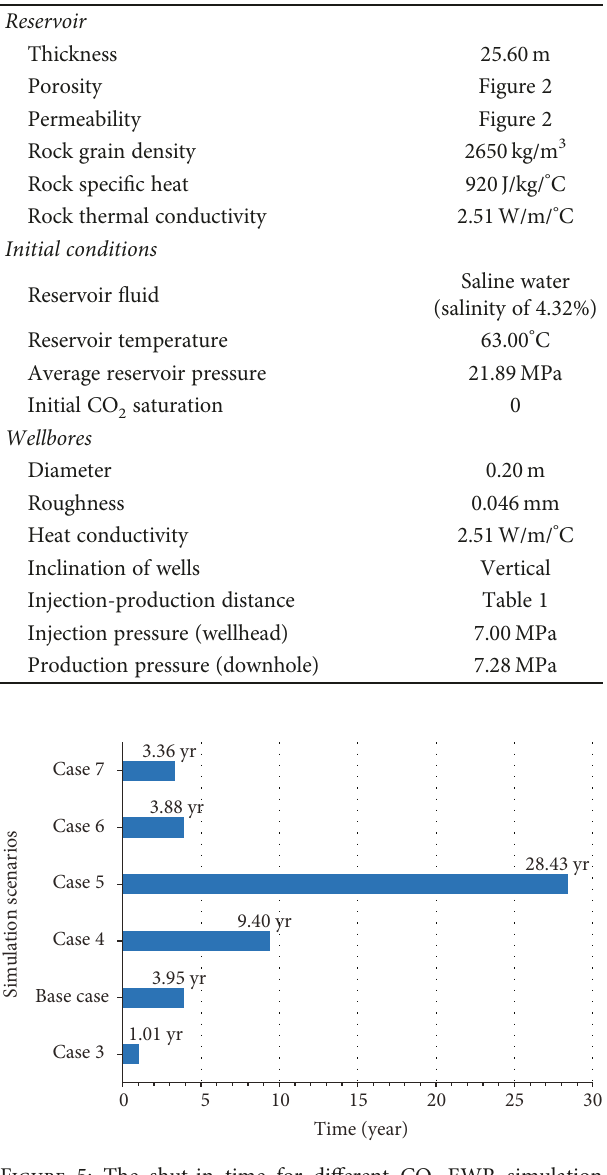
Table 2: Geometric and hydrogeological speci fi cations for the simulation.